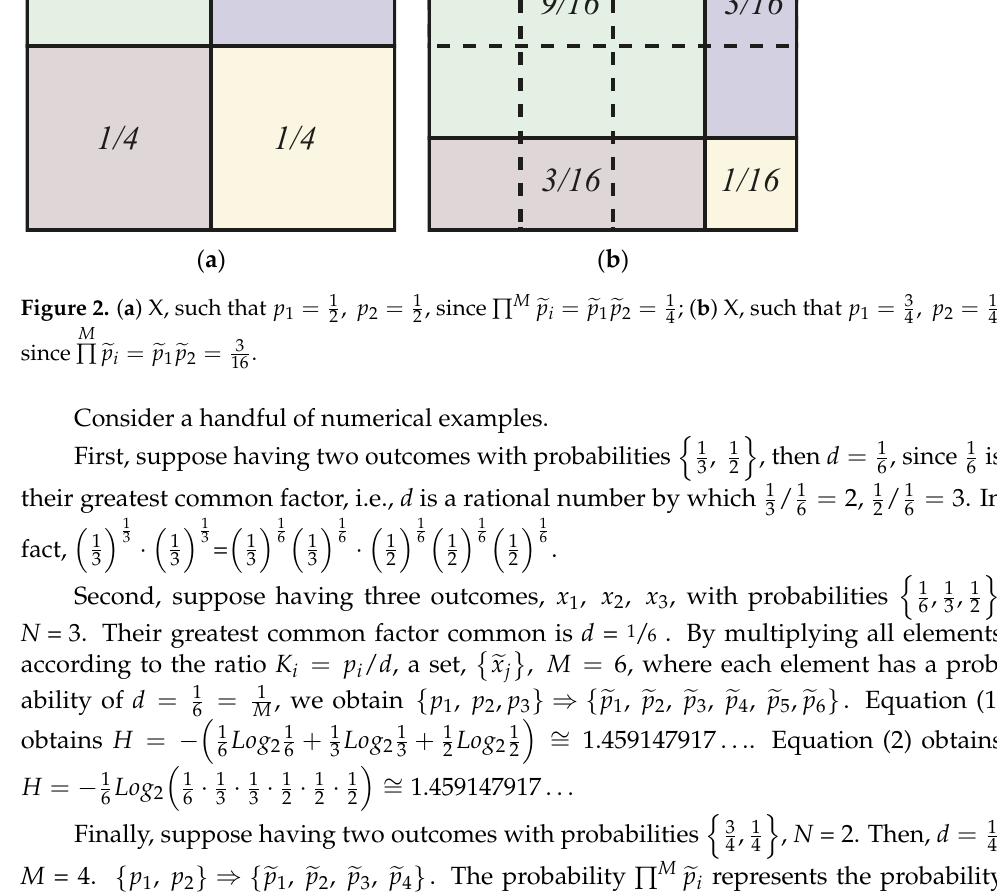
,𝑝 2 = 1 , since 4 4